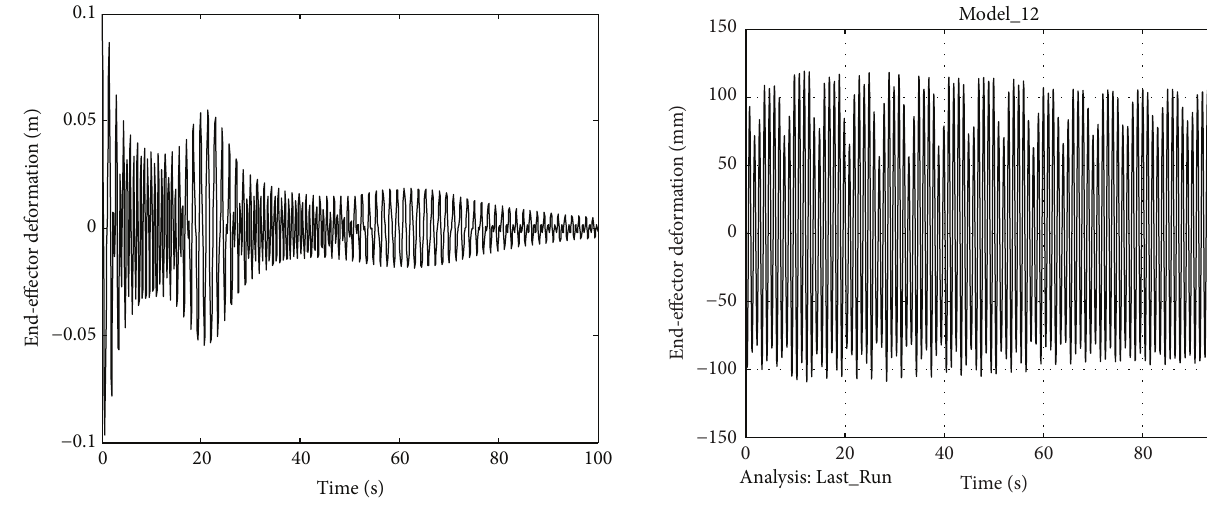
Figure 7: Response of the controlled fixed flexible arm.